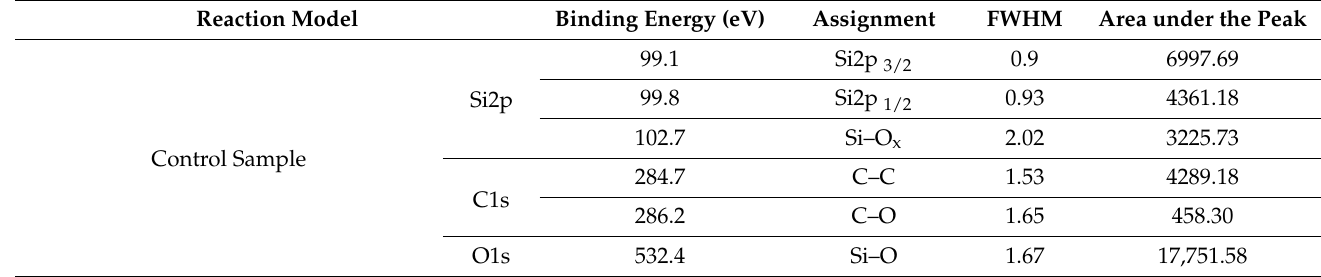
Table 1. Representative summary of peak assignments reported in this work. Reaction